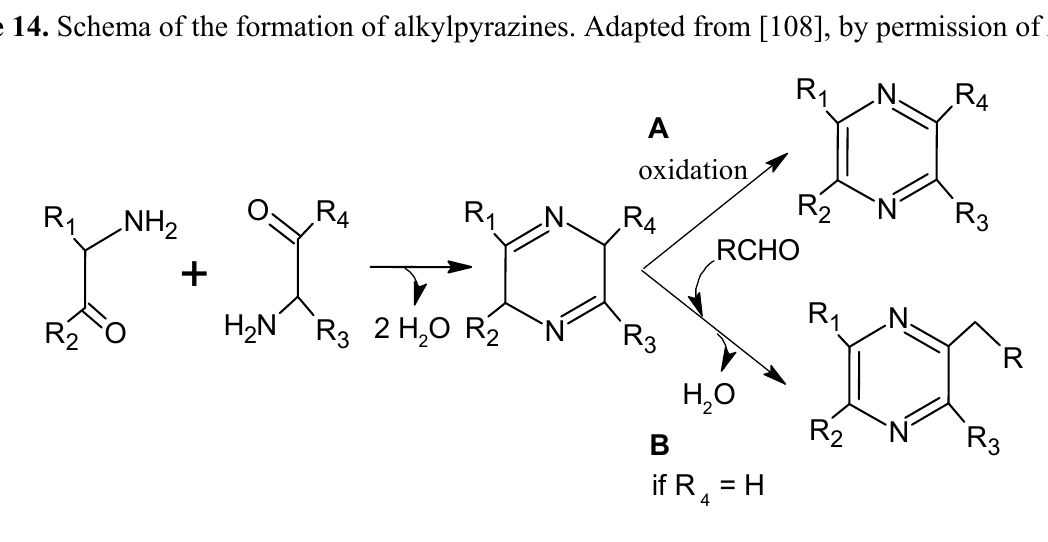
Figure 14. Schema of the formation of alkylpyrazines. Adapted from [108], by permission of